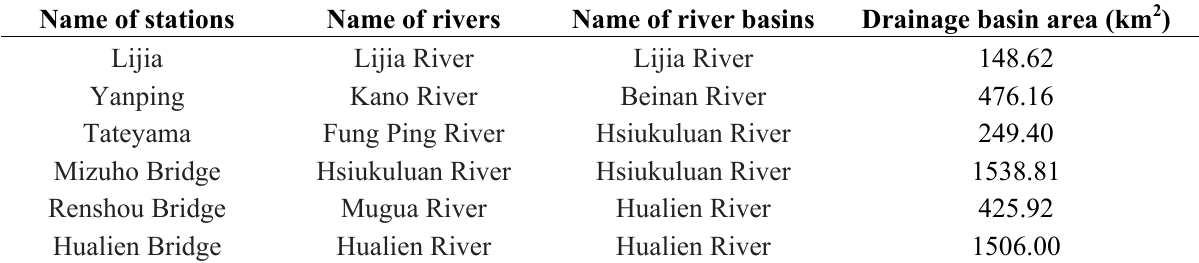
Table 2. The information of six hydrological stations in Eastern Taiwan.